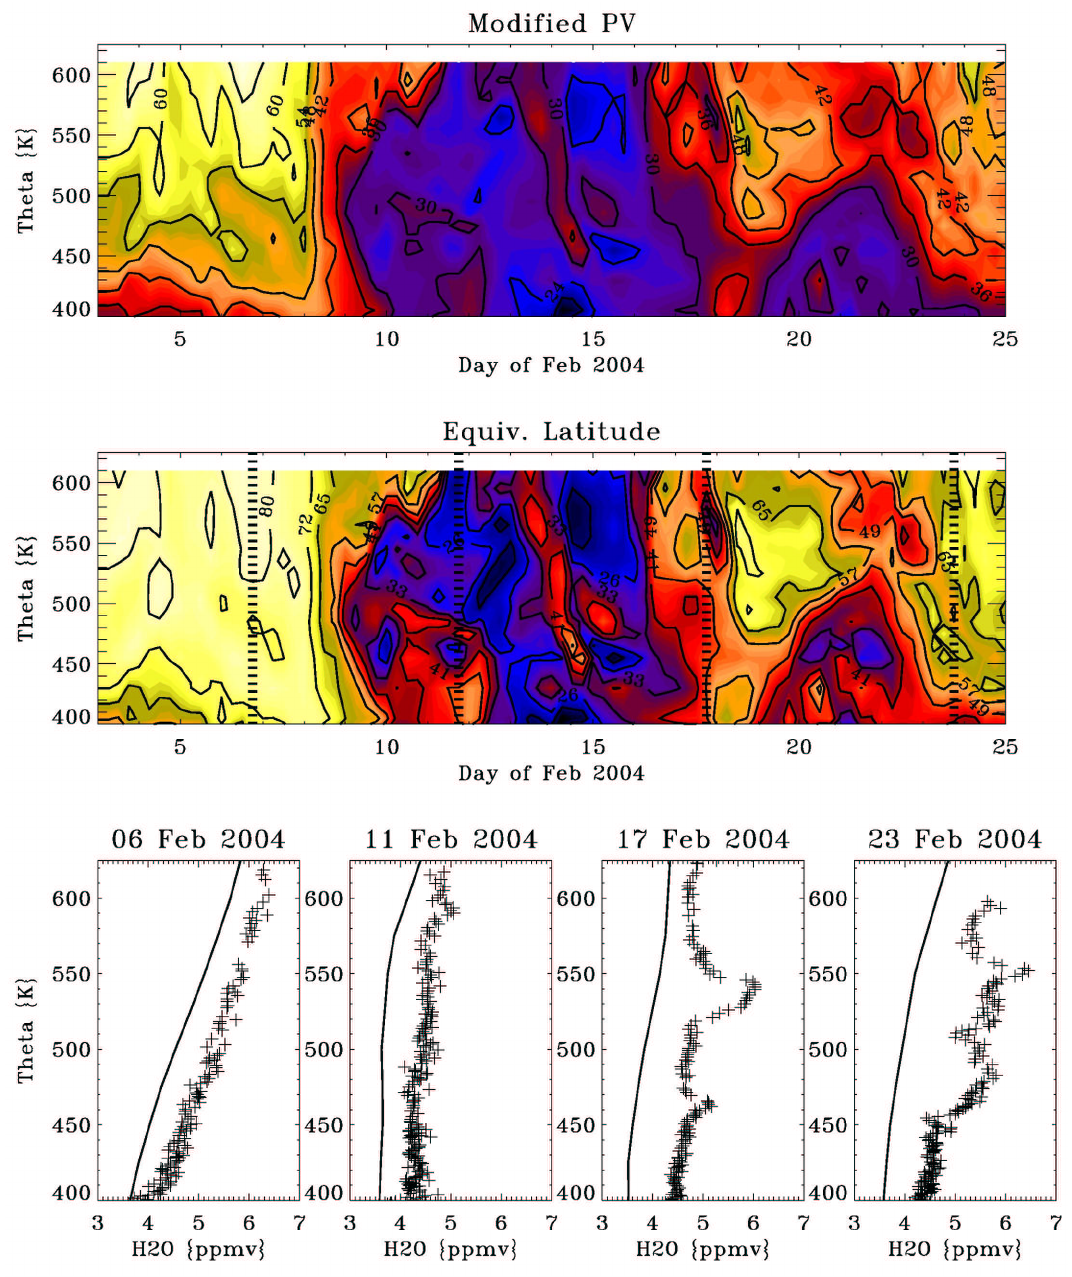
Figure 1. Upper panel: MIMOSA modified PV (Lait, 1994) normalized at 475 K, with contour lines every 6 PVU for the time period 01 to 25 February 2004 above Sodankylä. Centre panel: MIMOSA equivalent latitude (Nash et al., 1996) with contour lines every 8° for the same period, with dotted lines indicating the date of the profiles shown below. Lower panel: Profiles of water vapour from ECWMF T106 analyses (black lines), and as measured by FLASH (black crosses) on 06, 11, 17, and 23 February 2004.